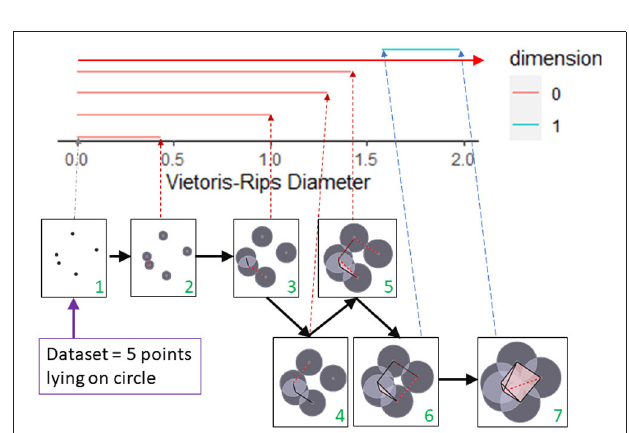
FIGURE 2 | A barcode captures topological features in a dataset at multiple scales. The topology of a dataset at a fixed scale is determined by joining pairs of data points with an edge if the distances between the pair of points is less than the fixed scale. If three edges form a triangle, then the triangle is filled in. This process is shown in the seven boxes as the scale for joining vertices increases from box 1 to box 7. The corresponding barcode is shown at the top of the figure. The persistence of a feature over multiple scales determines the length of the bar corresponding to that feature. The number of components ( β 0 ) that exist at a particular scale is represented by the number of red bars that exists at the corresponding Rips diameter. The creation of the 1-dimensional cycle in box 6 is represented by the birth of the blue bar. The blue bar dies when this cycle is filled in with triangles (box 7). This figure was created by modifying the output of the R package TDAstat (Wadhwa et al., 2018) and latex code written by Catalina Betancourt.